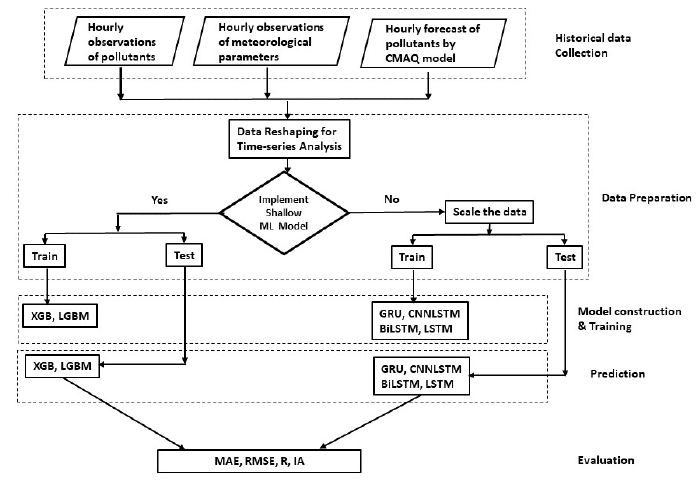
Figure 1. Experimentation